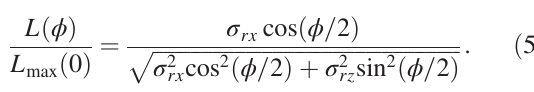
FIG. 2. Calculated LCS x-ray spectra (a) simulated with ε ¼ 1 mm mrad and (b) ε n